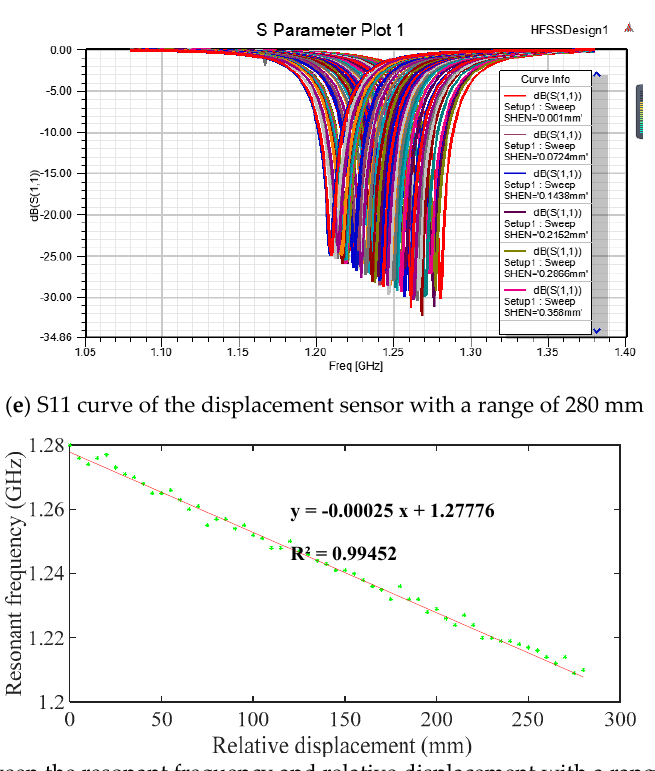
Figure 7. Simulation results of three types of displacement sensors.